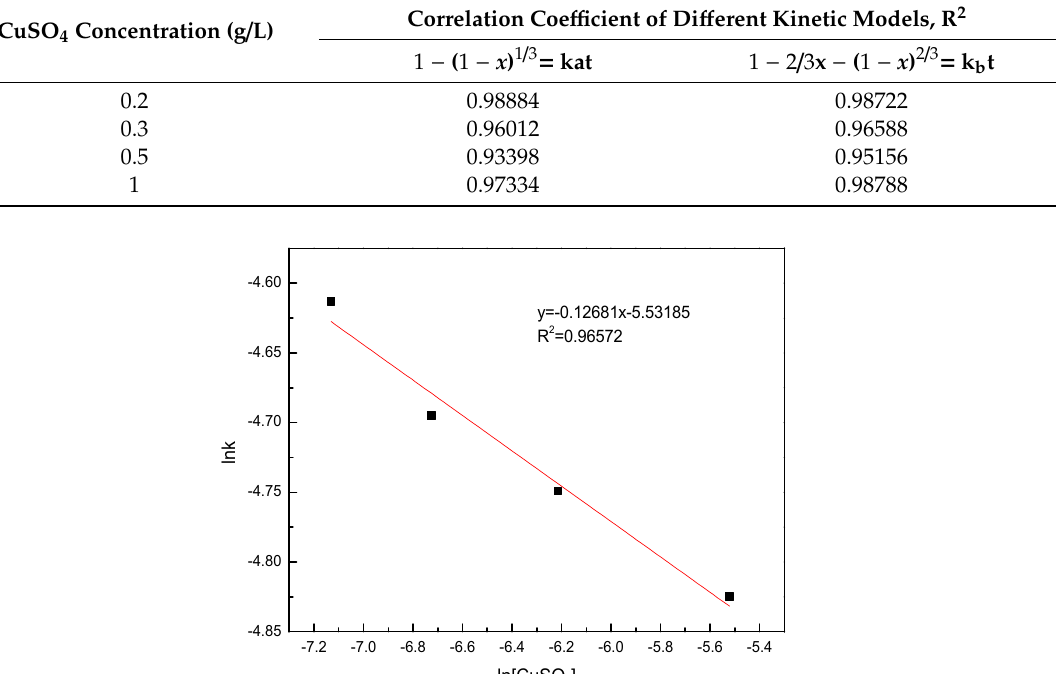
Figure 10. Arsenic removal kinetic at di ff erent CuSO 4 concentrations. Table 4. Correlation coe ffi cient (R 2 ) values for the di ff erent CuSO 4 concentrations and kinetic data. Correlation Coe ffi cient of Di ff erent Kinetic Models, R 2 CuSO 4 Concentration (g / L)